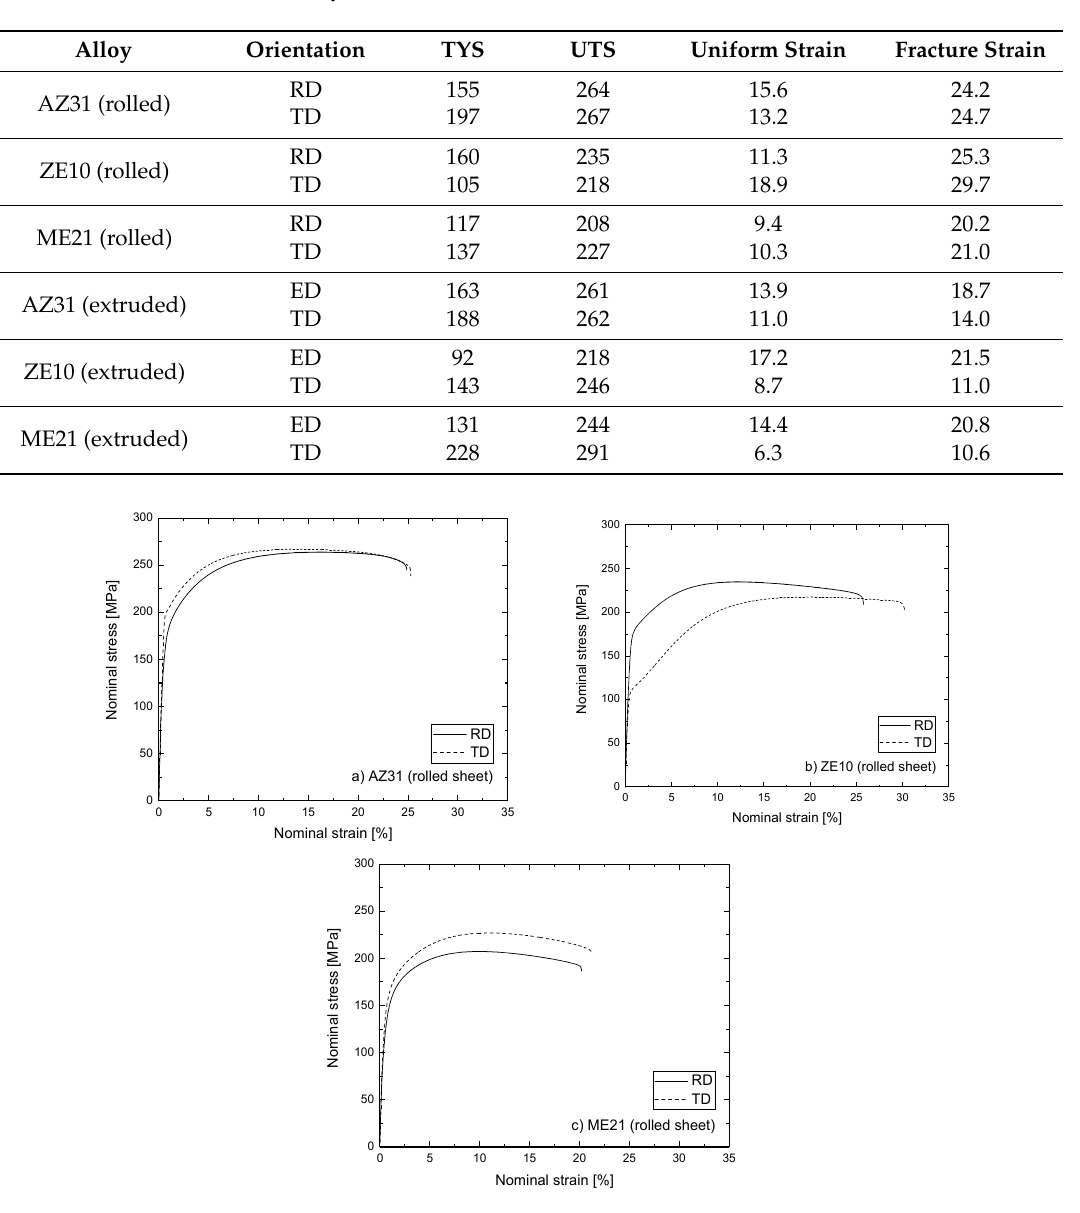
Figure 3. Stress–strain diagrams in the RD and the TD for the rolled magnesium sheets; ( a ) AZ31; ( b ) ZE10; ( c ) ME21.